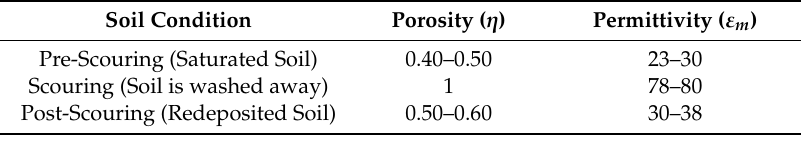
Table 2. Values of calculated permittivity during scouring process.